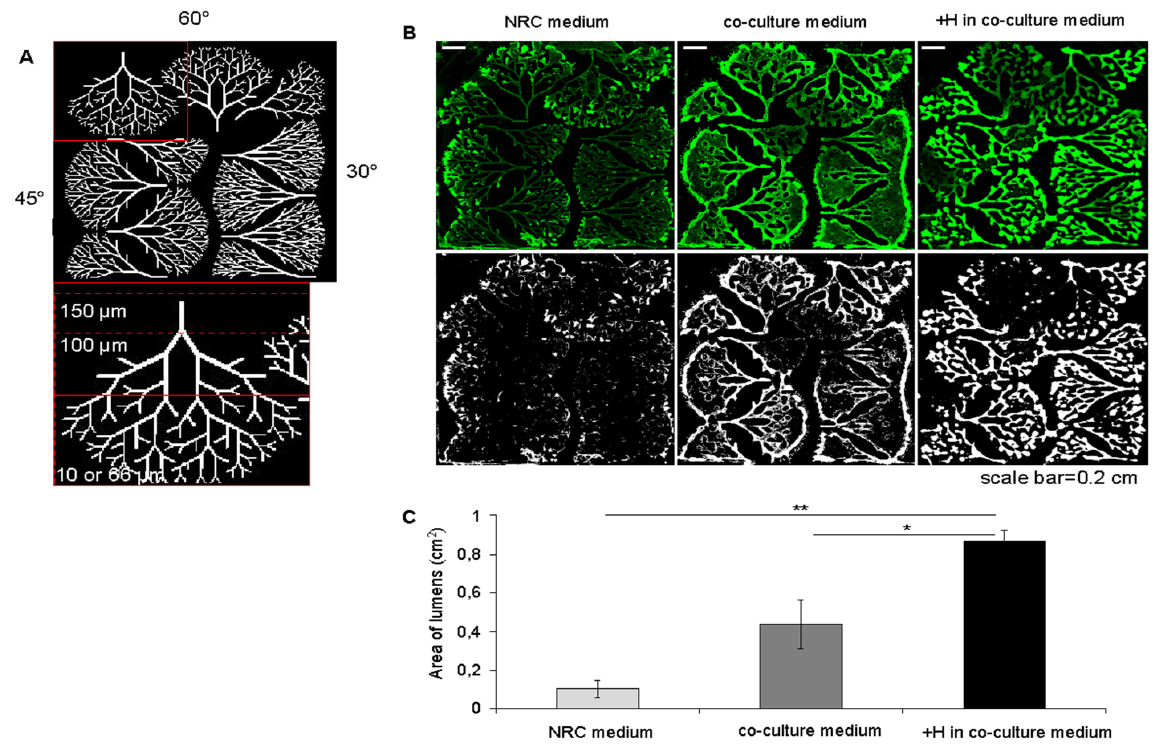
Figure 2. HUVECs enhance luminogenesis of 3D biliary networks. ( A ) photomask of the micropatterns showing physiologically relevant branch and angle dimensions. ( B ) fluorescein stained biliary network and corresponding binarized pictures illustrating the effect on tubulogenesis of pre-seeding HUVECs on micropatterns (scale bar = 0.2 cm). ( C ) luminal area quantification in NRC medium = NRCs alone cultured in NRC medium, co-culture medium = NRCs alone cultured in 50% NRC medium with 50% HUVEC medium, +H in co-culture medium = NRCs:HUVECs co-cultured in a 10:1 cell ratio in 50% NRC medium with 50% HUVEC medium, mean ± SEM, and N = 3 experiments per condition. One way ANOVA test with Tukey ′ s multiple comparisons test: NRC medium vs. +H in co-culture medium: p -value = 0.0018 < 0.01 **; co-culture medium vs. +H in co-culture p -value = 0.0273 < 0.05 *.